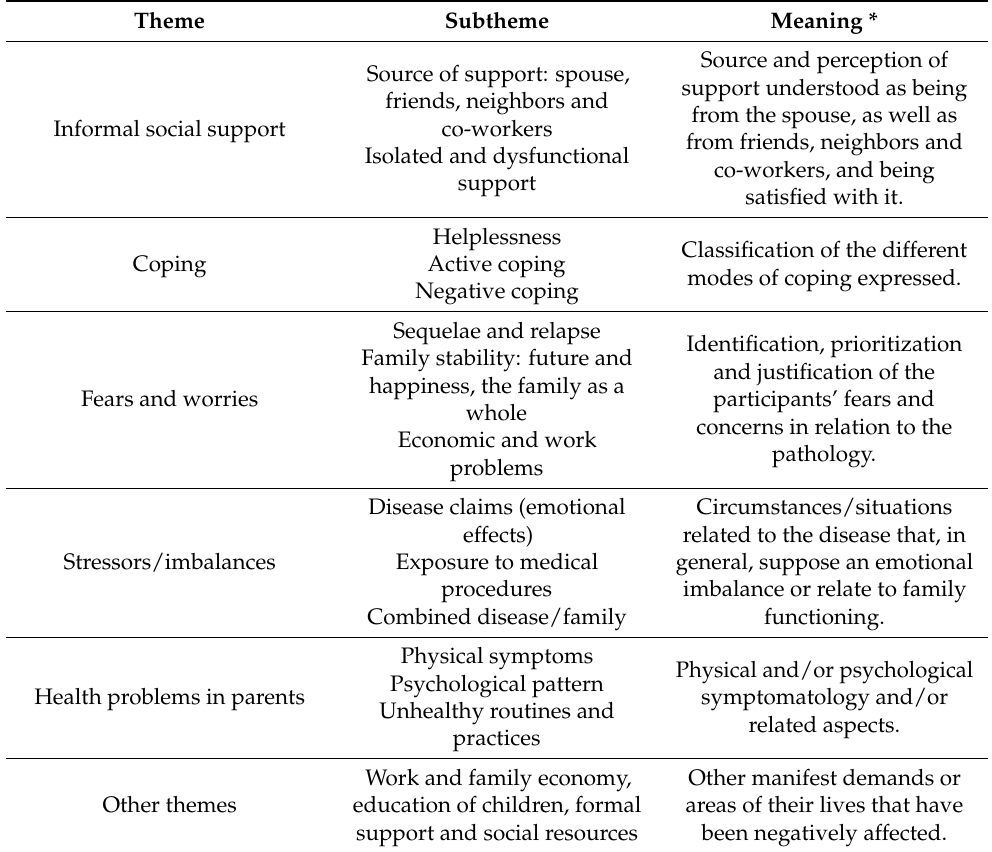
Table 2. Areas of need: Content Analysis Themes, Subthemes and